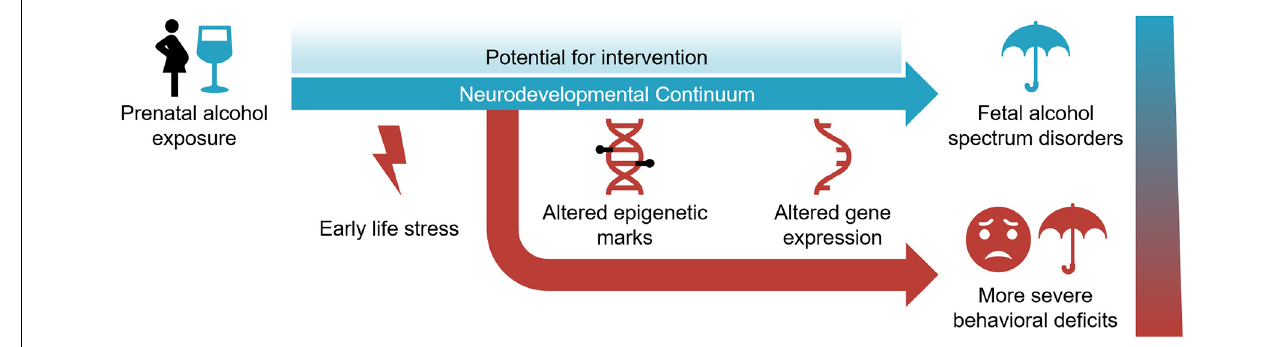
FIGURE 2 | The neurodevelopmental continuum is susceptible to PAE and early life stress (ELS) in the development and severity of fetal alcohol spectrum disorder. Epigenetic modifications and gene expression are affected by these environmental exposures. While it represents a sensitive period for environmental assaults, the dynamic nature of the neurodevelopmental continuum also offers potential for